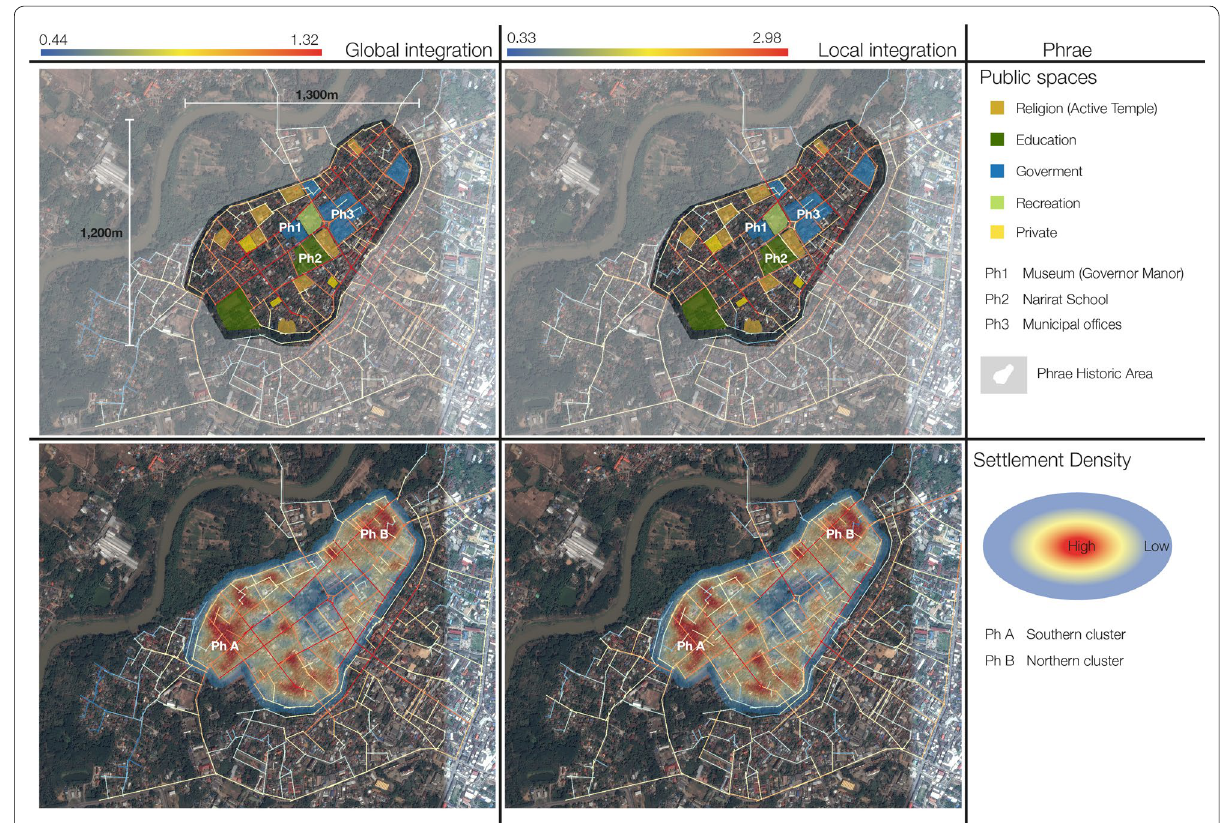
Fig. 7 Analysis of Phrae’s spatial